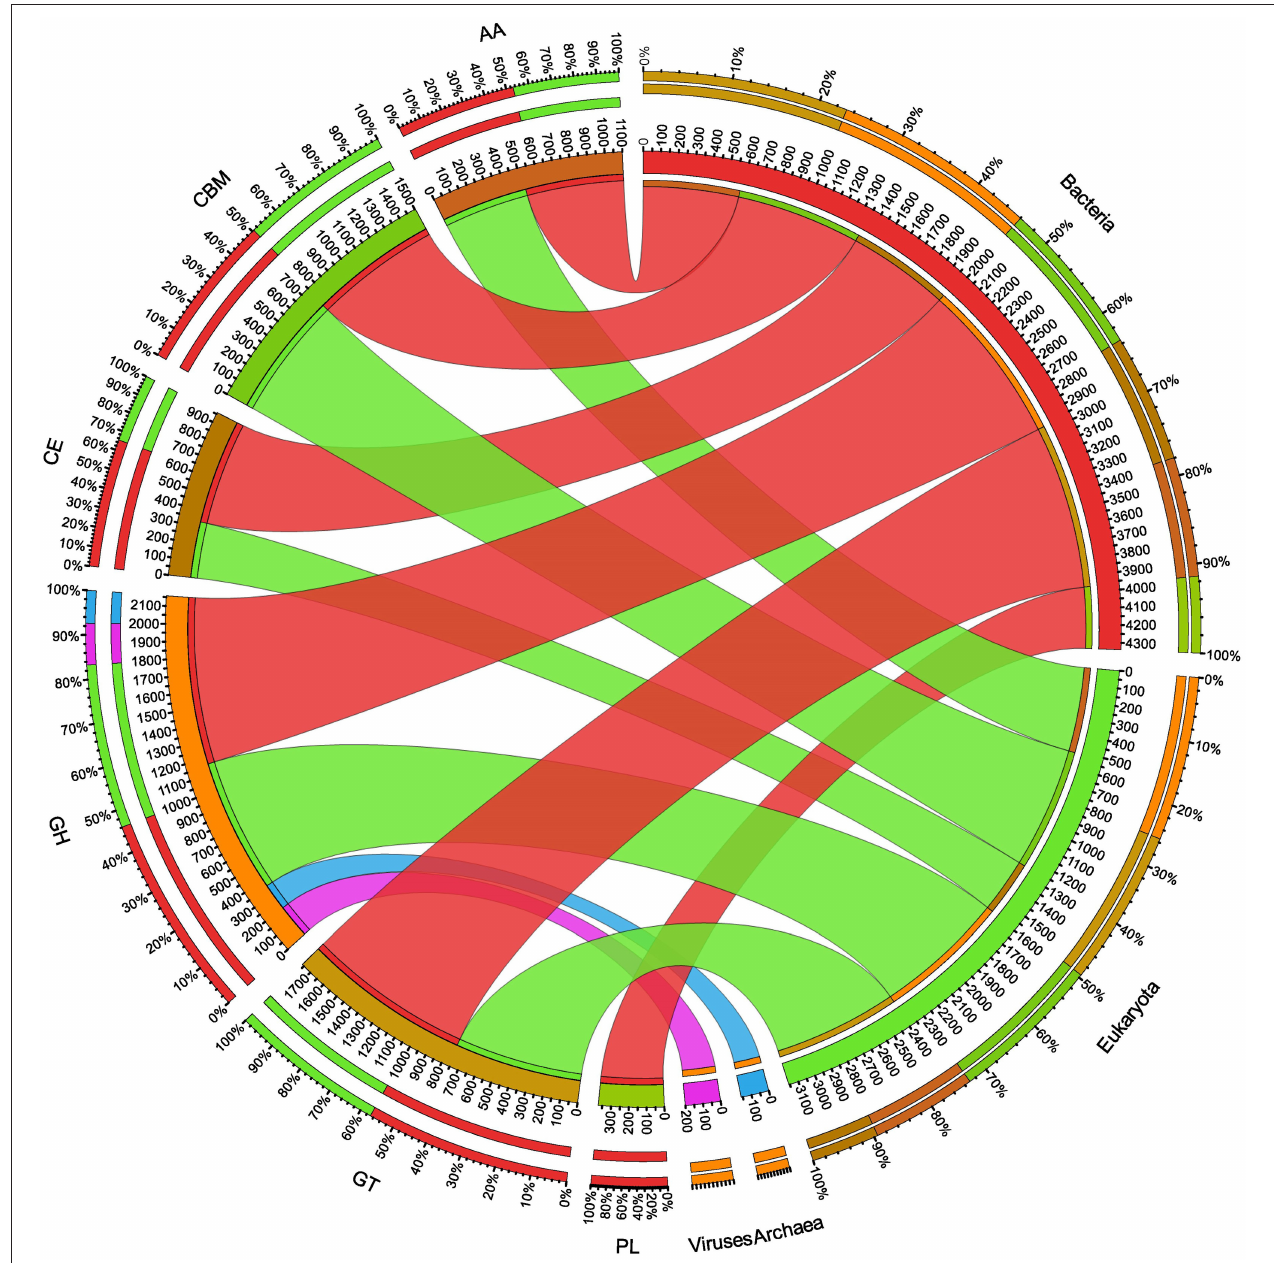
FIGURE 9 | Circos plot representation of the carbohydrate-active enzymes of SR1 at the Kingdom level.